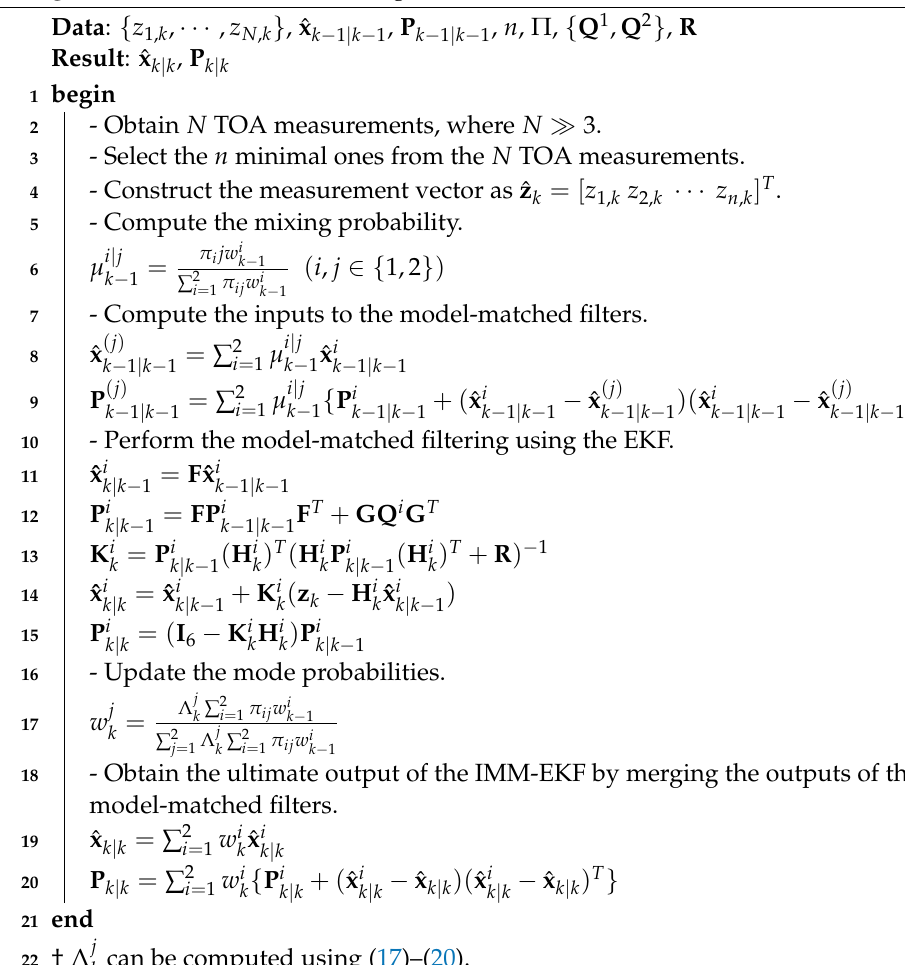
Algorithm 1: 3D localization using the IMM-EKF and NN TOA